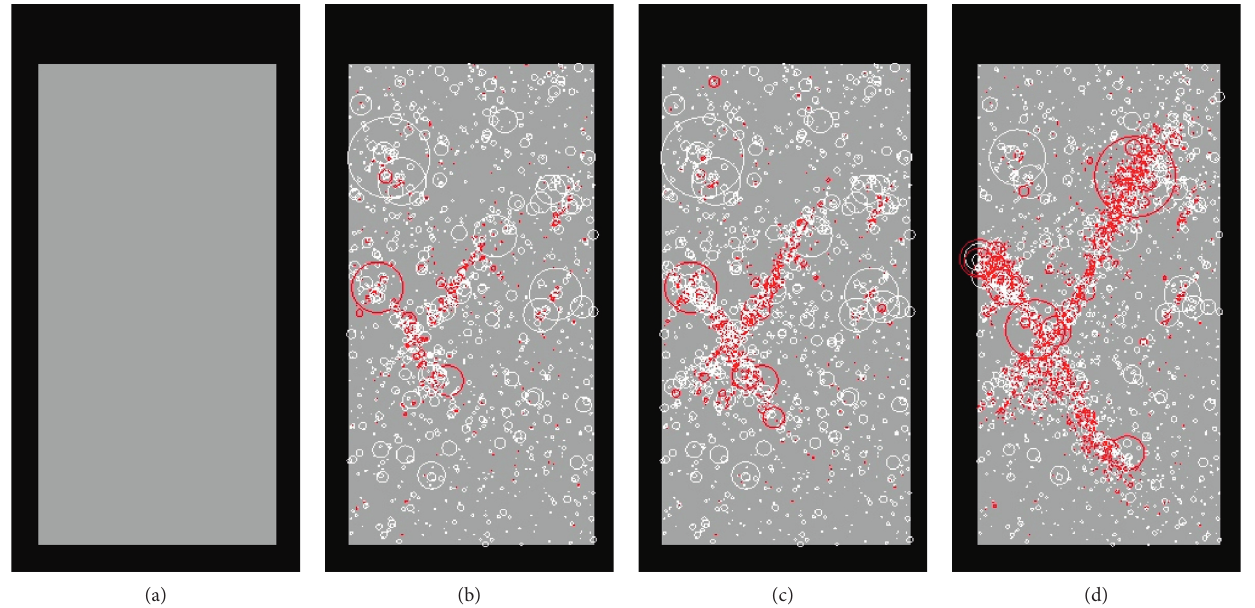
Figure 13: Acoustic emission of rock mass at ratio of height to diameter of 2.